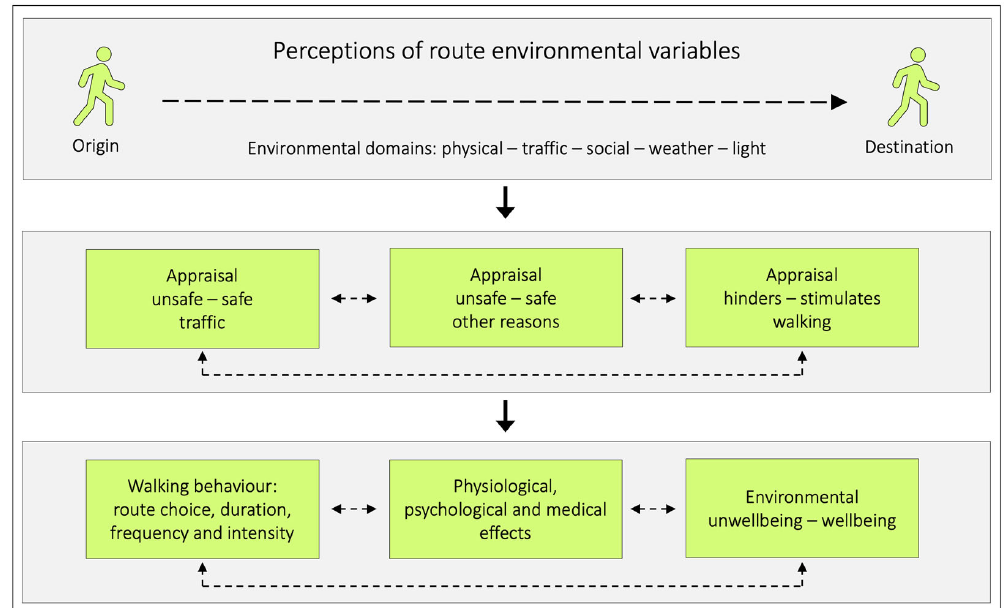
Figure 1. A conceptual model illustrating how perceptions of variables in different route environmental domains may affect pedestrians (modified from [15]). Route environments consist of different environmental domains: the physical environment (stationary objects such as buildings and trees), the traffic environment (mobile objects such as pedestrians, and cars causing e.g., noise, exhaust fumes and particulate matter (PM)), the social environment (interaction between individuals), weather (wind, rain, sun etc.), and light conditions (natural and artificial light). These environmental domains represent a number of predictor variables, whereof some (e.g., noise and exhaust fumes), have the roles of also representing basic variables (e.g., flow and speeds of motor vehicles). They can, thereby, be interpreted as intermediate outcomes. Perceptions of predictor variables in the initial level of the model, can influence how we appraise unsafety–safety due to traffic, and unsafety–safety due to other reasons (such as crime), as well as how we appraise the environment with respect to if it is hindering–stimulating walking. These appraisals can, consecutively, affect our walking behaviour (such as route choice and the amount of walking), have physiological, psychological, and medical effects, and affect our environmentally induced unwellbeing–wellbeing. The bidirectional hatched lines between the boxes indicate potential mutual relationships.